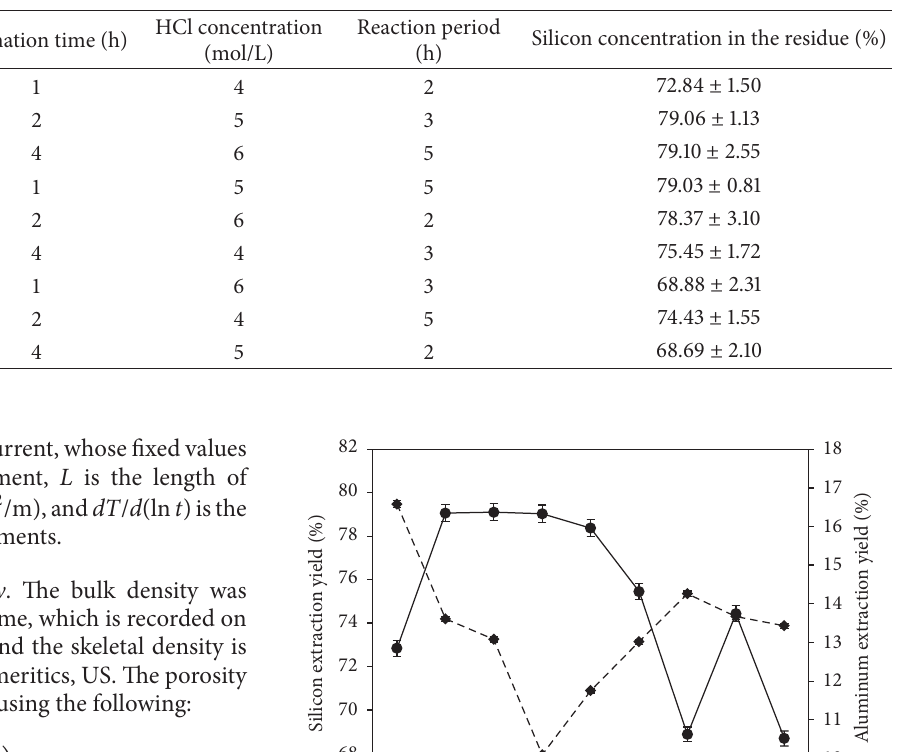
Table 2: Acid leach experiment of the coal gangue.